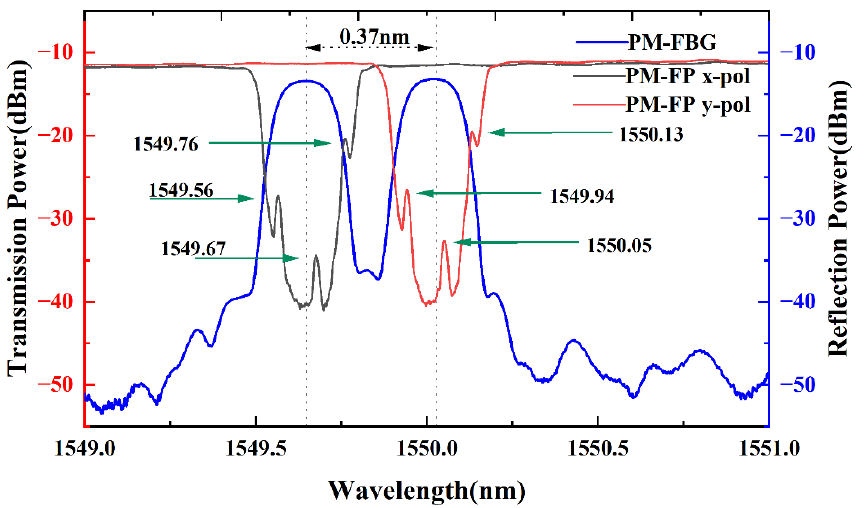
Figure 2. Reflection spectrum of the PMFBG (blue curve) and transmission spectrum of the PMFBG- FP in a single polarization state (black and red curves).